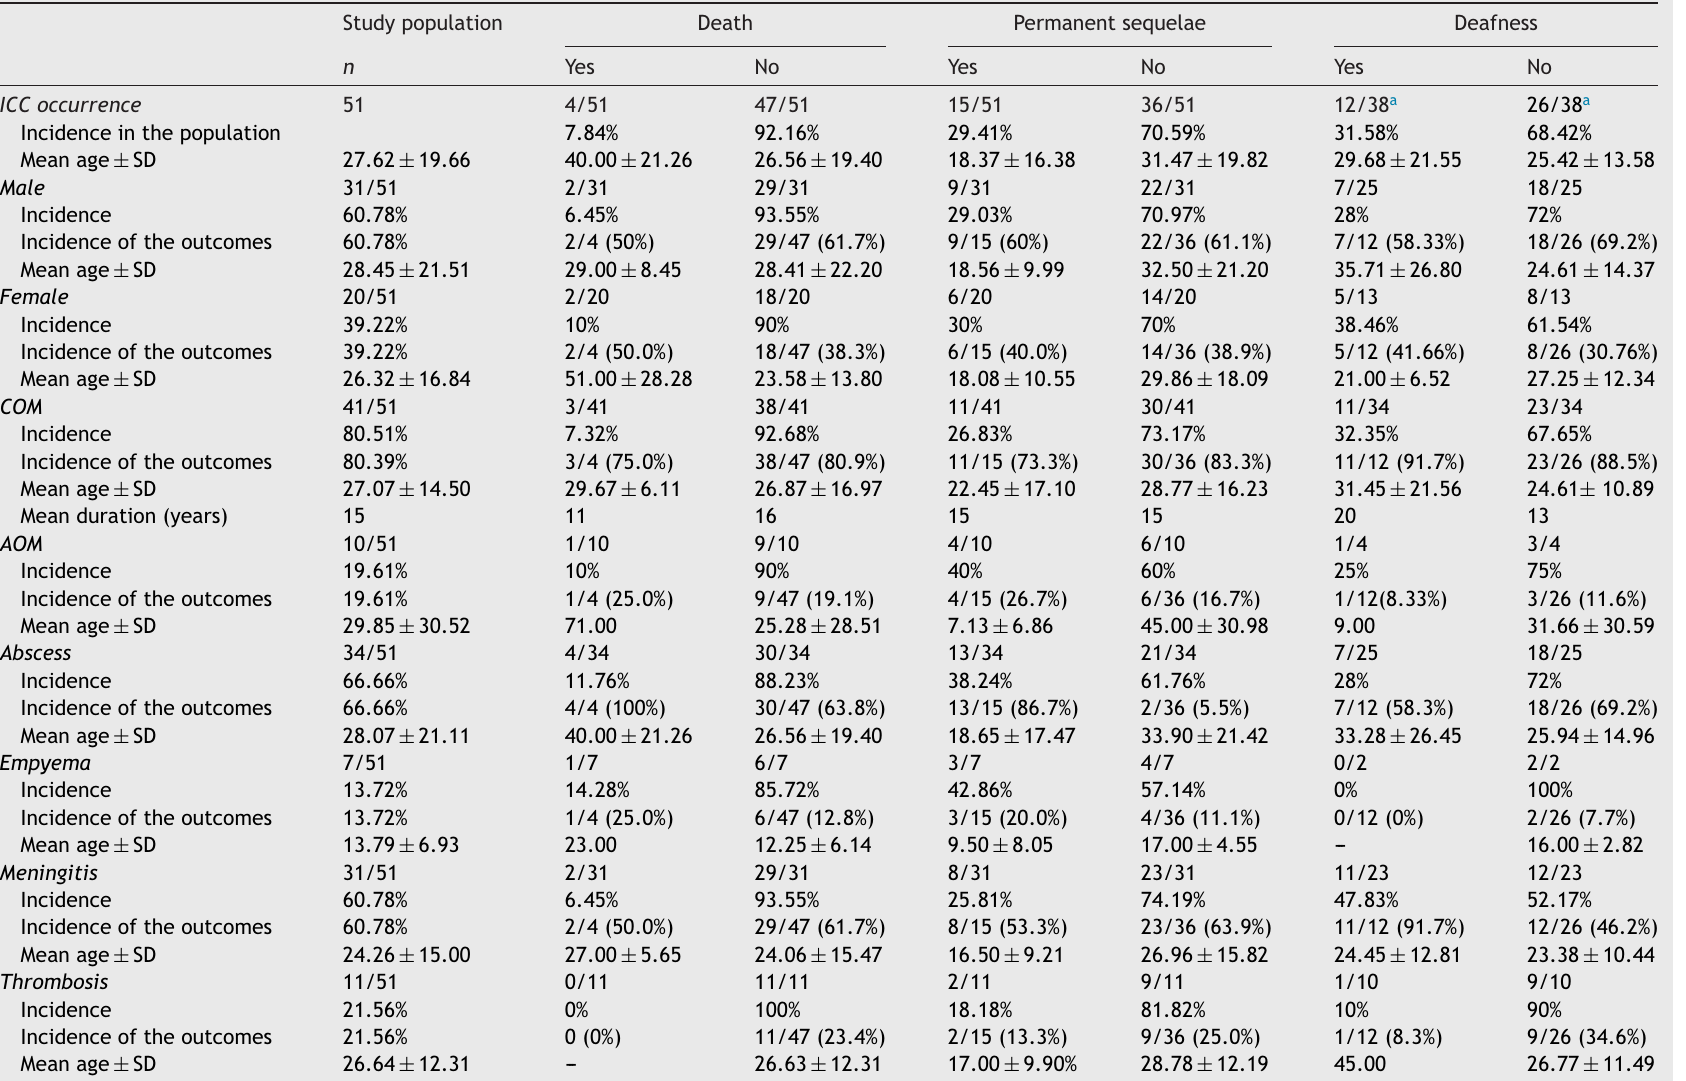
Incidence of the outcomes of death, permanent sequelae, and deafness in relation to age, gender, diagnosis of otitis and major intracranial